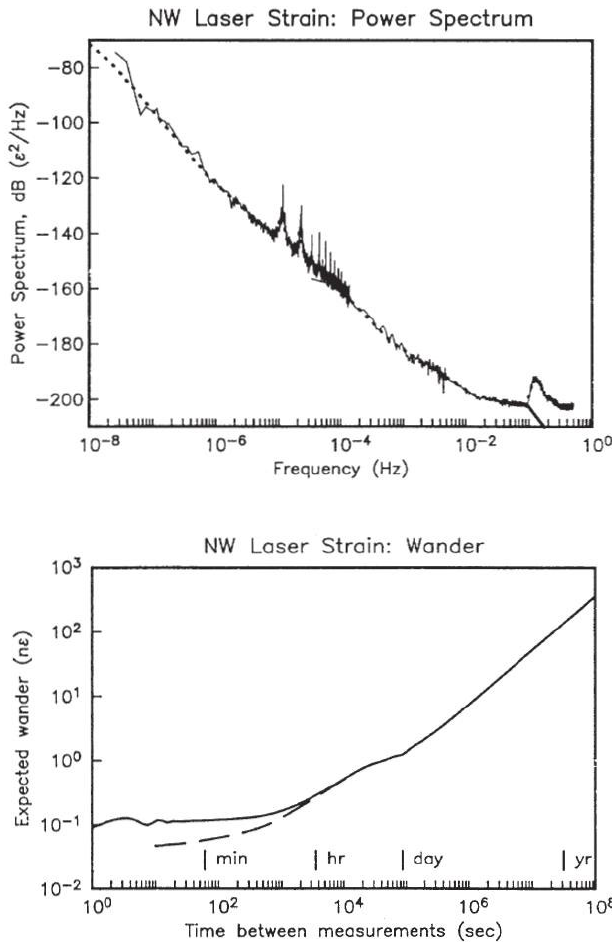
FIG. 21. (top) PSD of the earth strain at Pino Flat Observatory in southern California; (bottom) the solid line is rms wander of the earth computed from the full spectrum, and that computed if the ‘‘7-second’’ microseism peak is filtered out, from [32].